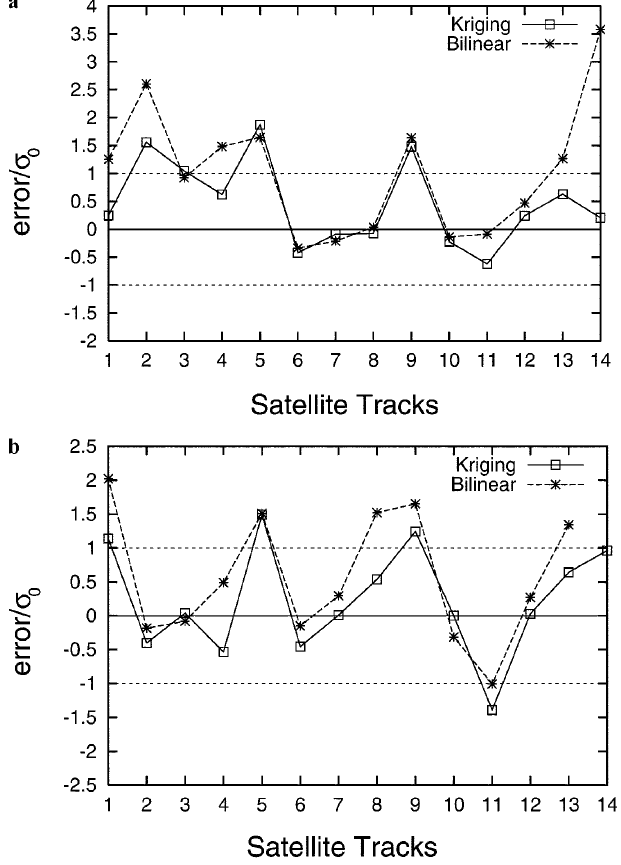
Fig. 4. a Biases between SBUV data and those found by interpolation with kriging and by bilinear interpolation from Delaunay triangula- tion versus satellite tracks. Biases are normalized by the original standard deviation. Results correspond to areas of gaps in the 14 satellite tracks for the total ozone field on October 19, 1988. b Biases between SBUV data and those found by interpolation with kriging and by bilinear interpolation from Delaunay triangulation versus satellite tracks. Biases are normalized by the original standard deviation. Results correspond to areas of gaps in the 14 satellite tracks for layer 5 on October